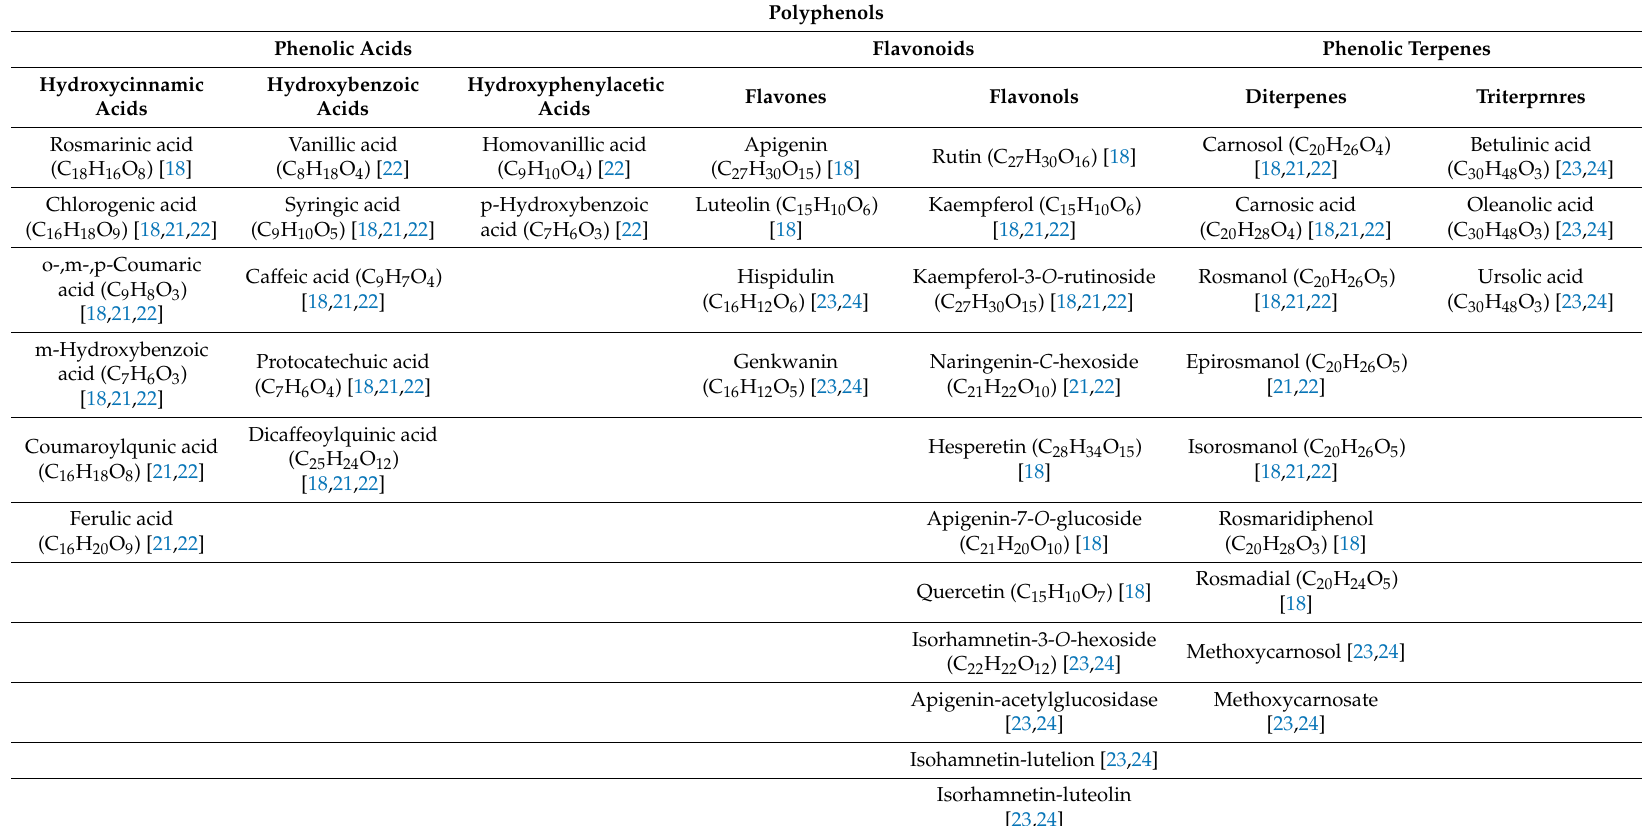
Table 1. Polyphenolic profile of Rosemary extract